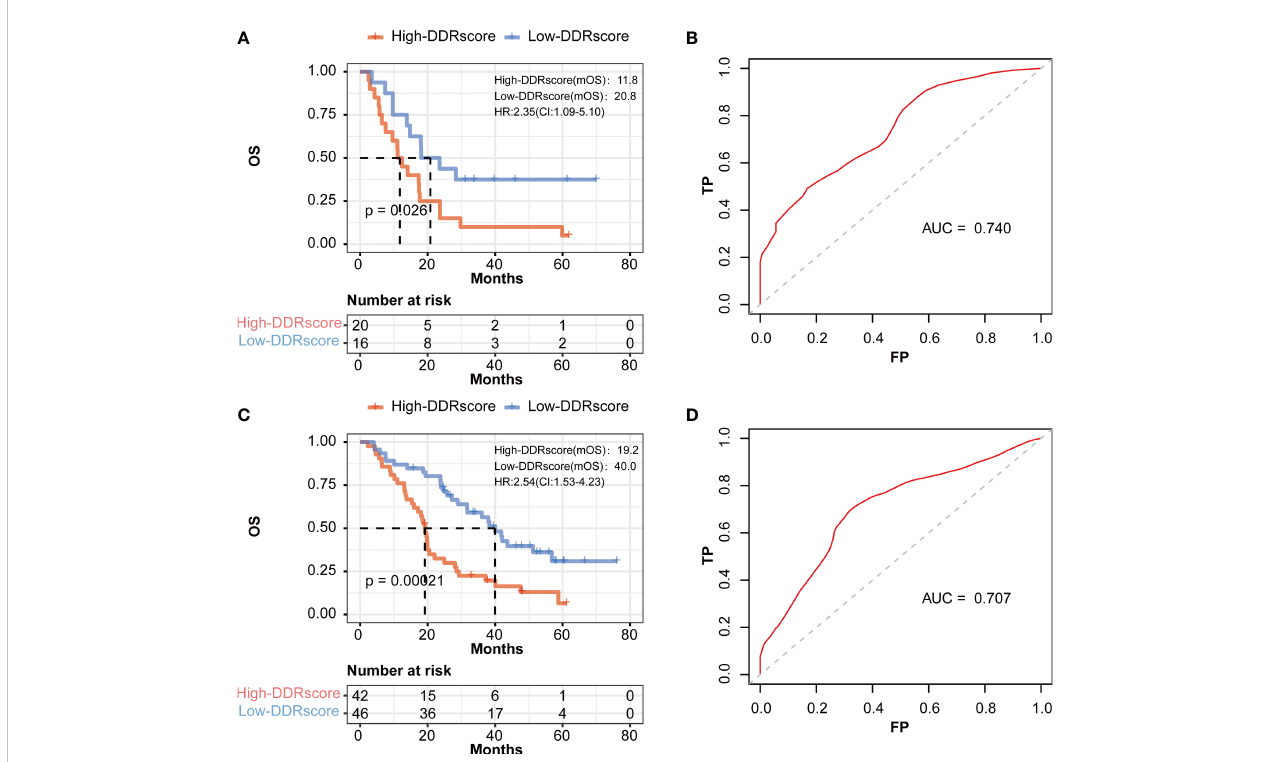
FIGURE 5 The prognostic value of the DDRscore model in the different sides of colon in mCRC patients. (A) Kaplan-Meier plot for OS based on DDRscore of four- DEGE gene signature of patients with LmCRC and RmCRC(B) in the GSE72970-LmCRC cohort. (B) AUC of time-dependent ROC curves in the GSE72970-LmCRC cohort. (C) Kaplan-Meier plot for OS based on DDRscore of four-DDR gene signature of patients with RmCRC(B) in the GSE72970- RmCRC cohort. (D) AUC of time-dependent ROC curves in the GSE72970-RmCRC